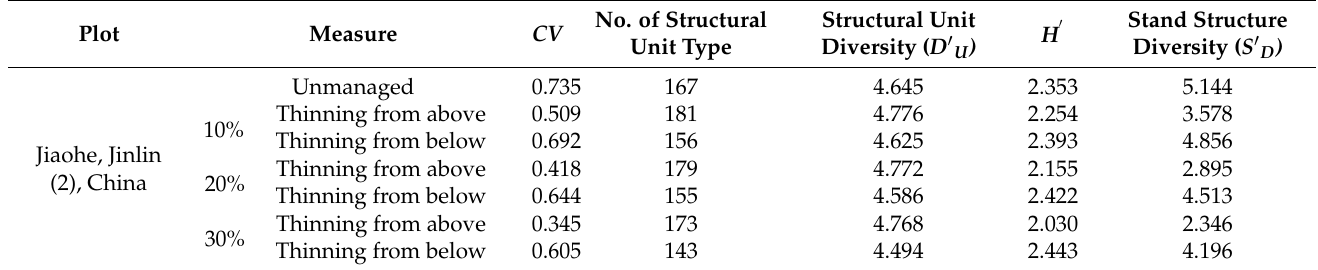
Table 6. Comparison of stand structure diversity of six different simulated thinning methods in Jiaohe, Jinlin (2),